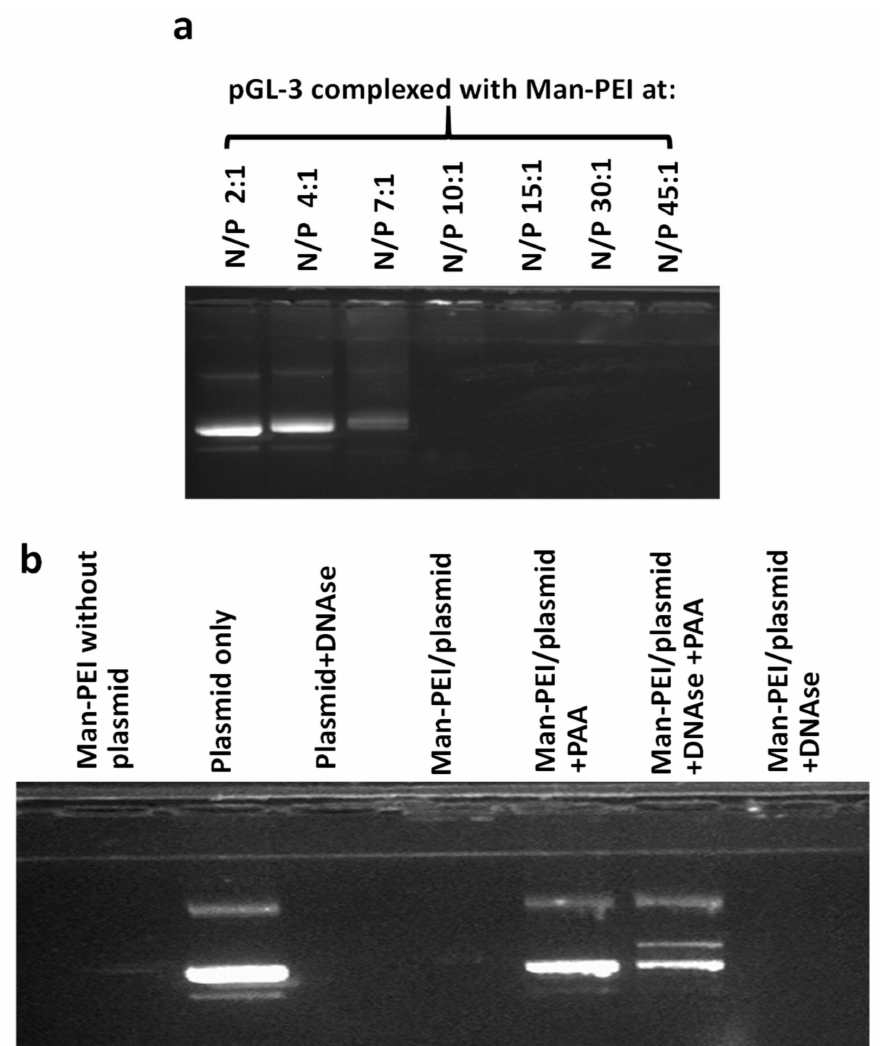
Figure 3. Gel retardation assays through agarose electrophoresis to evaluate Man-PEI’s complexation with plasmid DNA, at different N/P ratios. ( a ) Increasing N/P ratios between Man-PEI and pGL-3 plasmid presented a progressive decrease in plasmid detection in the gel; ( b ) Plasmid alone or complexed with Man-PEI at N/P ratio of 20:1 was incubated in the presence of DNAses